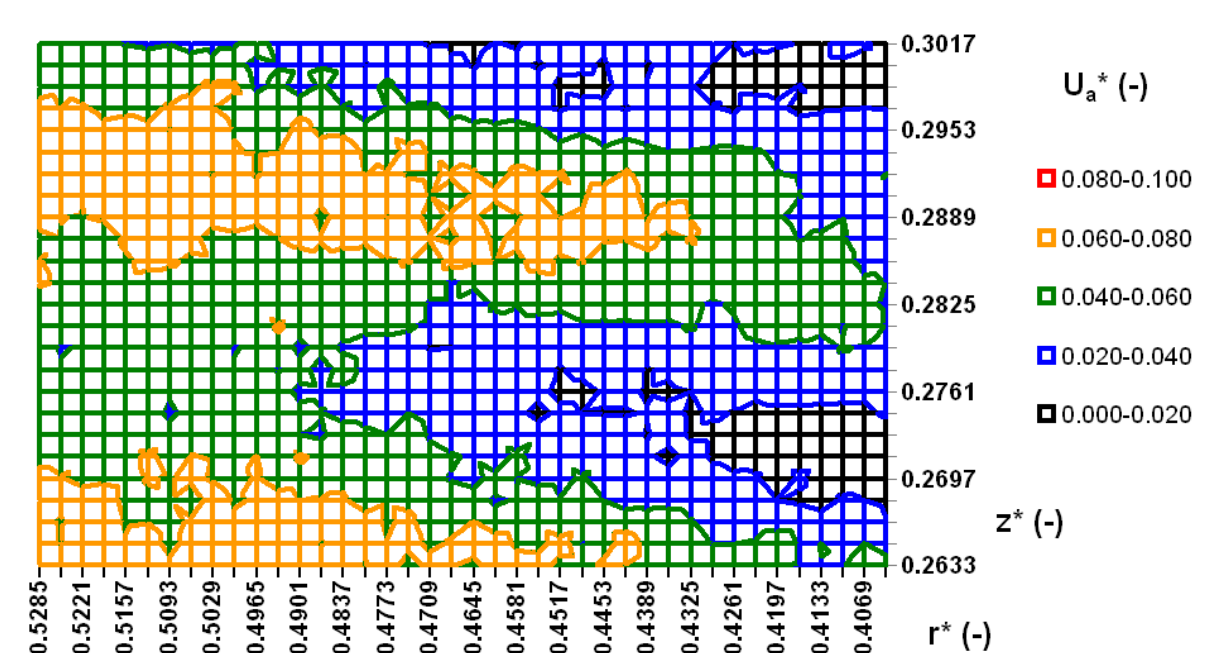
Fig. 3. Dimensionless axial mean velocity distribution U ax* = )/( NDU